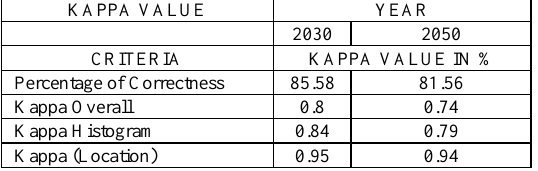
Table 3: Validation using Kappa